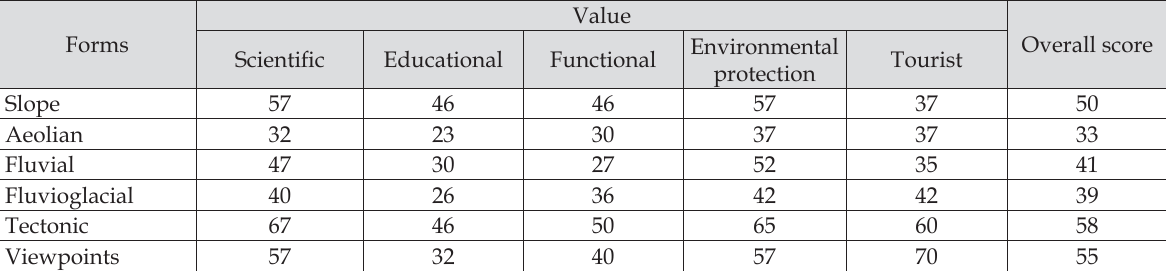
Table 2. Mean ratings of geosites by genetic group (expressed in % of the maximum score)